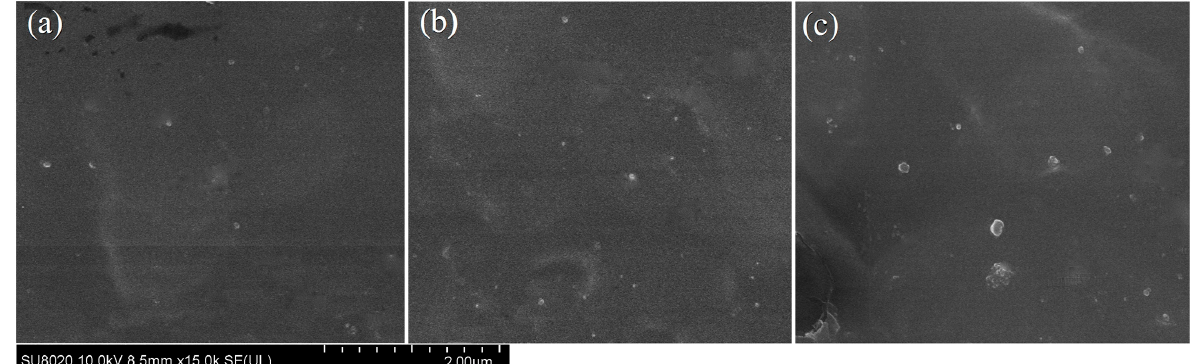
Figure 5. Cross-sectional SEM images: ( a ) 0.5wt%TMPTA-s-SiO 2 /XLPE, ( b ) 1.5wt%TMPTA-s-SiO 2 /XLPE and ( c ) 1.5wt%SiO 2 /XLPE nanocomposites.